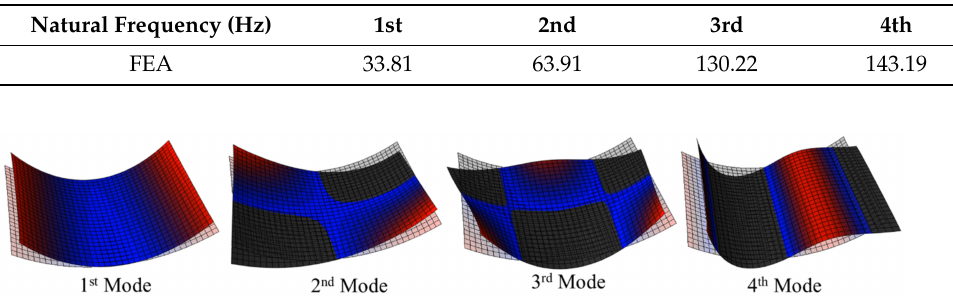
Figure 7. Associated mode shapes with the first four natural frequencies around the first stable